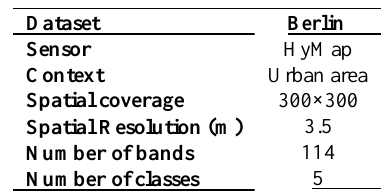
Table 1. The main characteristics of the Berlin